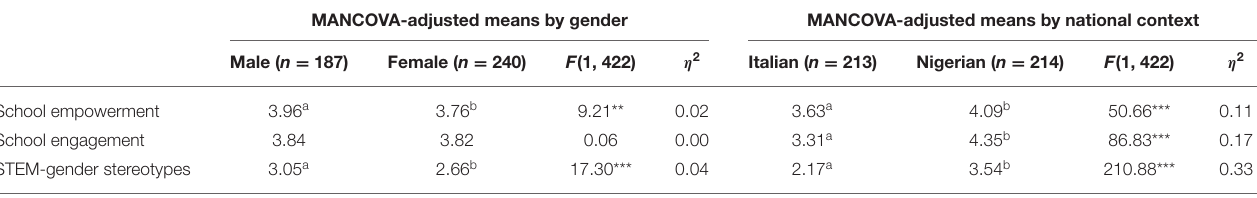
TABLE 4 | Univariate analyses of covariance and pairwise comparisons for gender and national context (Italian vs. Nigerian) on school empowerment, school engagement, and STEM-gender stereotypes. MANCOVA-adjusted means by gender MANCOVA-adjusted means by national context